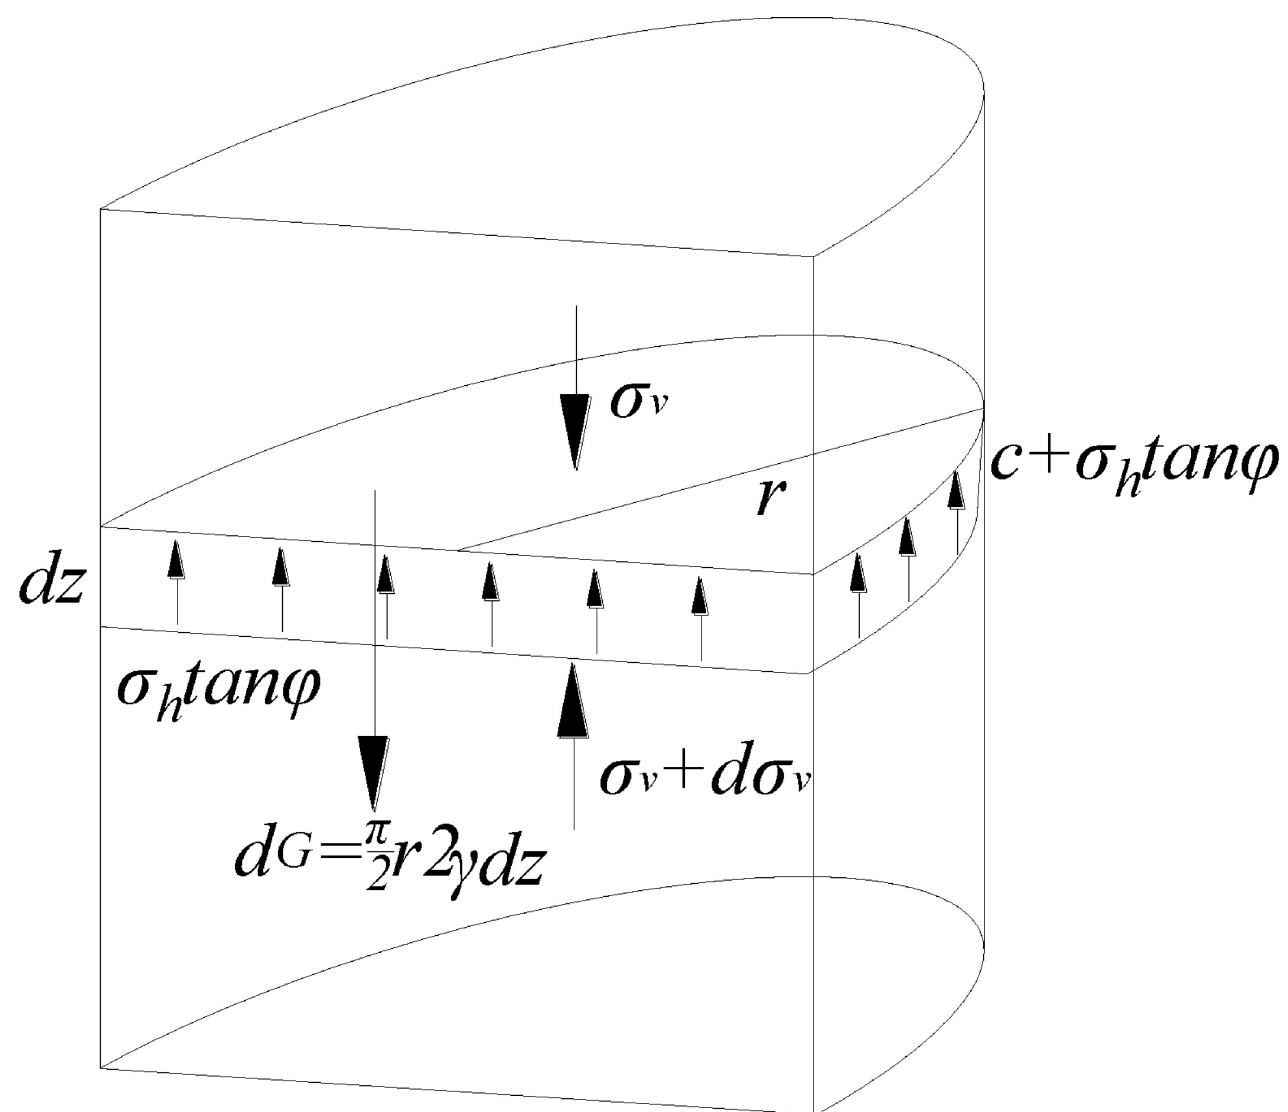
Fig 11. Schematic of modified soil arching theory